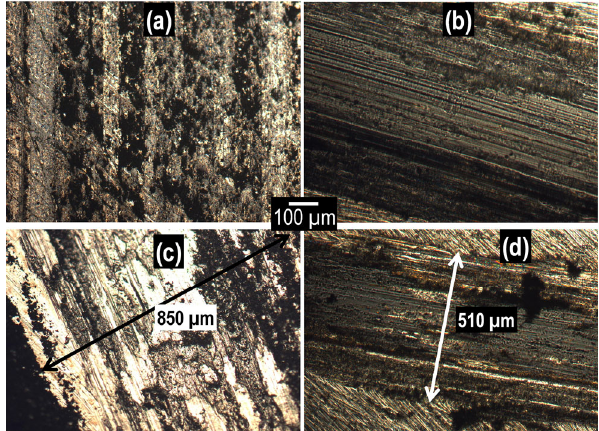
Fig. 8 Optical images of the POD tribometer tracks of graphite generated with (a) pin and (b) ball loading tests and tribometer tracks generated with ball loading tests for (c) GO-ODA and (d) GO-ANS at 30 N normal load in ambient condition.